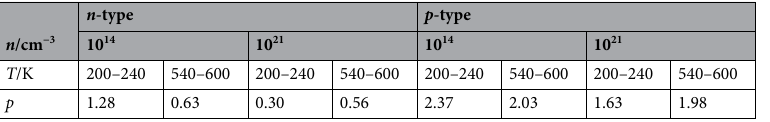
Table 1. Power index p of the temperature dependence of specific resistivity ρ( T ) (4) for the extrinsic n - and p -type electric carriers in Cu 7 PS 6 calculated by using AMSET code, v0.4.11 30 (https:// hacki ngmat erials. lbl. gov/